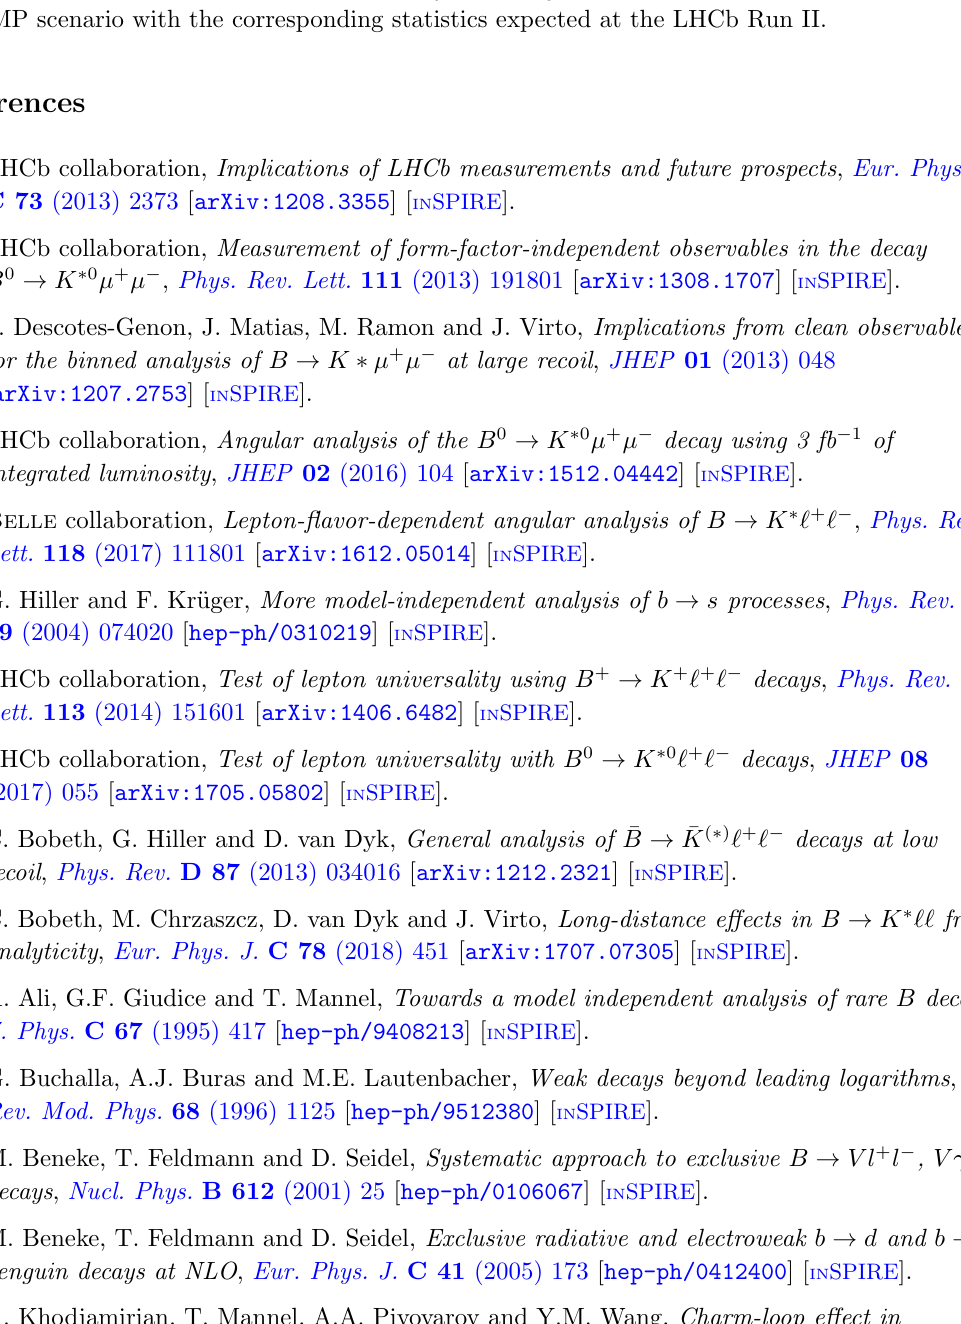
and C NP for z 2 (cid:12)ts. Ensembles are produced for 9 10